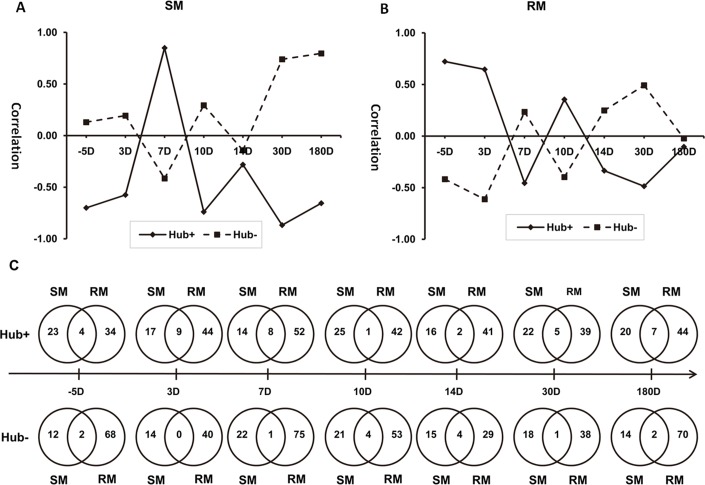
Pearson correlation between Hub+ and Hub- gene expression patterns.(A) Hub genes in SM-specific GCNs. (B) Hub genes in RM-specific GCNs. (C) Overlapping gene expression patterns of Hub+ and Hub- genes in SMs and RMs after SIV infection (range: 5–180 days). The frequency of the overlapping Hub+ genes (1–9) is significantly higher than that of the Hub- genes (0–4).